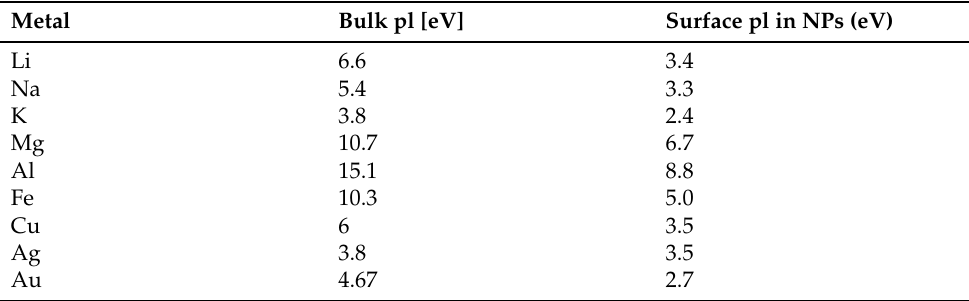
Figure 5. Spectral dependence of light absorption in a spherical Au nanoparticle with a varying radius. ( A ). Theoretically-found dependence in the model of the damping of plasmons in Au nanospheres on size-dependent Lorentz friction [17]. ( B ). Comparison of the Lorentz friction model with experimental results. ( C ). The experimental data for the absorption spectra of Au nanoparticles with varying radii reveal very good agreement with the Lorentz friction model ( A ) [17]. The most pronounced dipole mode of surface plasmons is dominant at sufficiently low sizes of the particle, when dipole approximation holds (i.e., when the resonant wave-length is much larger than the radius of the nanoparticle). For larger nanoparticles, the quadrupole surface plasmon resonance, slightly blue-shifted, additionally appears (indicated by the shadowed region in panel ( D ), where the corresponding Comsol simulation is presented [45]). The arising of the quadrupole mode is also visible in the experimental data in ( C ) for an Au nanosphere with a radius equal to 75 nm. Table 2. Plasmon energies measured in